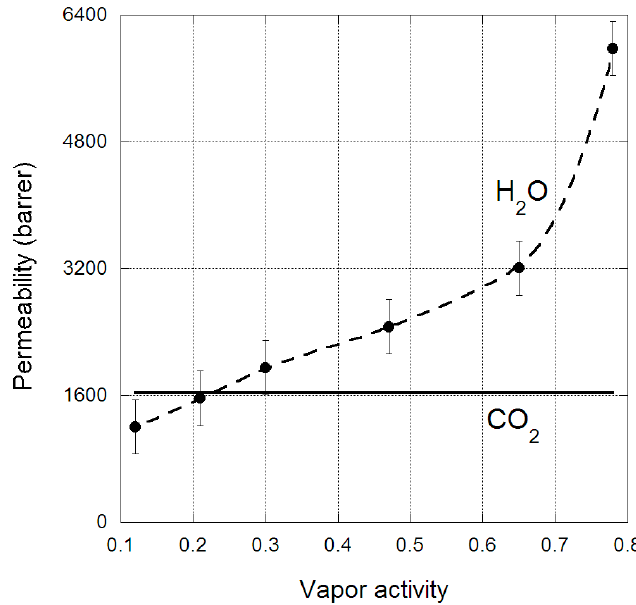
Figure 2. Permeability (barrer) of water and CO 2 through composite PIM-1 membranes under mixed gas conditions for a total thickness of 43 µm at 35 °C, for different water activities.